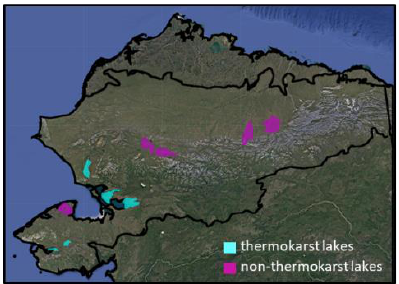
Figure A2. Lake sub-regions that correspond with relatively homogenous thermokarst (non-yedoma) and non-thermokarst lakes (including yedoma and glacial lakes).